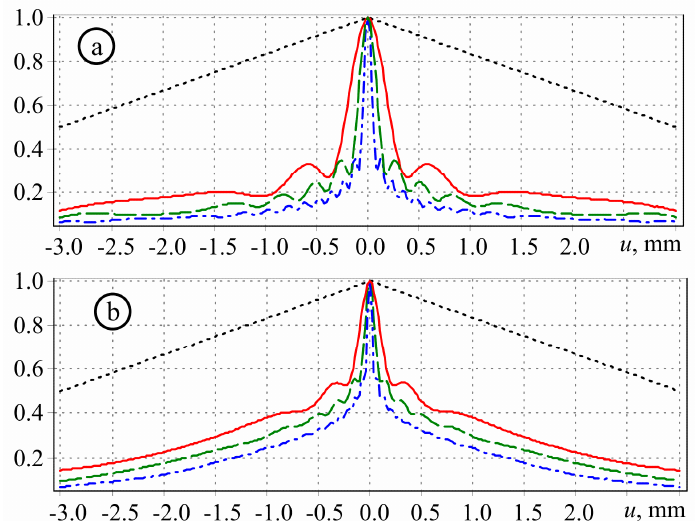
Figure 9. The MTF in the focal plane for n = 3 ( a ) and n = 5 ( b ) depending on the parameter α , with α = 0 (without apodization, dotted line), α = 0.0005 (solid line), α = 0.001 (dashed line), and α = 0.002 (dash-dotted line), for λ = 550 nm.